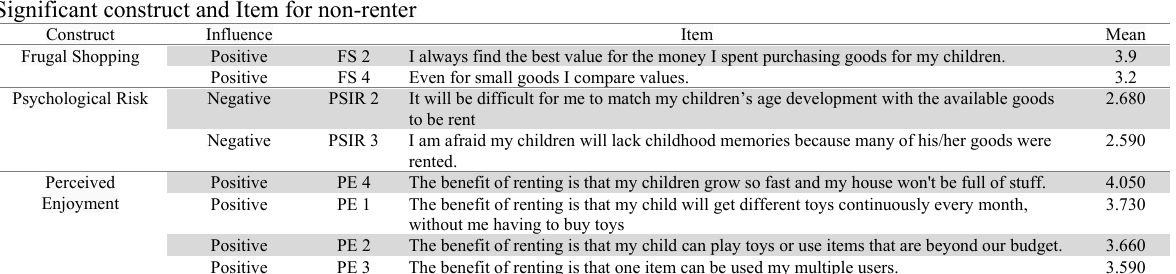
The R 2 for the non-renter economy risk, functional risk, psychological risk, social risk, frugal shopping, and perceived enjoy- ment can explain attitude by 48.2% and 40.1% for perceived enjoyment. The R 2 for the renter economy risk, functional risk, psychological risk, social risk, frugal shopping, and perceived enjoyment can explain attitude by 46.1% and 46.4% for per- ceived enjoyment. Table 6 Hypotheses Test for Non-Renter Hypotheses Convenient H1 Economic risk negatively influenced consumer attitude of renting toy and equipment for children. Rejected Economic risk negatively influenced Consumer perceived enjoyment of renting toy and equipment for chil- dren by perceived H2 Functional risk negatively influenced consumer attitude of renting toy and equipment for children H3 Psychological risk negatively influenced consumers attitude of toy and equipment renting for children. Rejected Psychological risk negatively influenced consumers perceived enjoyment of toy and equipment renting for children. H4 Social risk negatively influenced consumers attitude of toy and equipment renting for children. Rejected Social risk negatively influenced consumers perceived enjoyment of toy and equipment renting for children. Frugal shopping positively influenced consumers attitude of toy and equipment renting for children. H6 Consumers perceived enjoyment of toy and equipment renting for children are positively influenced attitude.